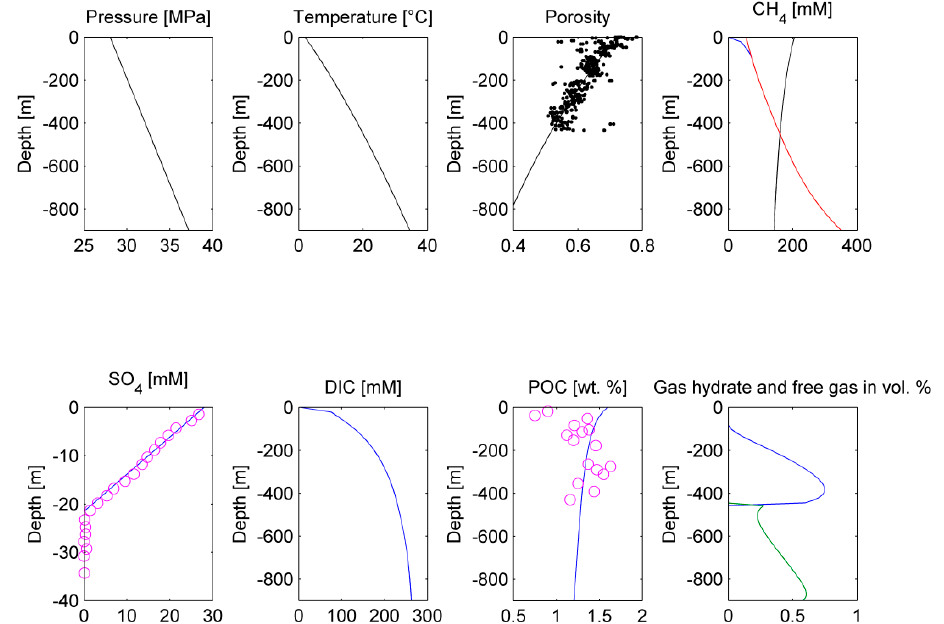
Figure 3. Modeling results for the Scenario 1. Upper panel, from the left: Pressure, temperature, porosity, and dissolved CH 4 concentration plots. Porosity measurements [20] are depicted as black dots, the modeling solution is represented by the black line. On the CH 4 concentration plot, red line depicts the phase boundary between gas hydrate and dissolved methane, black line represents the phase boundary between free gas and dissolved methane, and blue line states dissolved methane concentration. Gas hydrate and/or free gas formation occurs wherever dissolved methane concentration exceeds one of the solubility curves. Lower panel, from the left: SO 4 , dissolved inorganic carbon (DIC), POC, and gas hydrate/free gas concentration plots (in blue and green, respectively). On the SO 4 and POC concentration plot, measured values are presented as pink circles [20], whereas model predictions are shown as the blue lines.